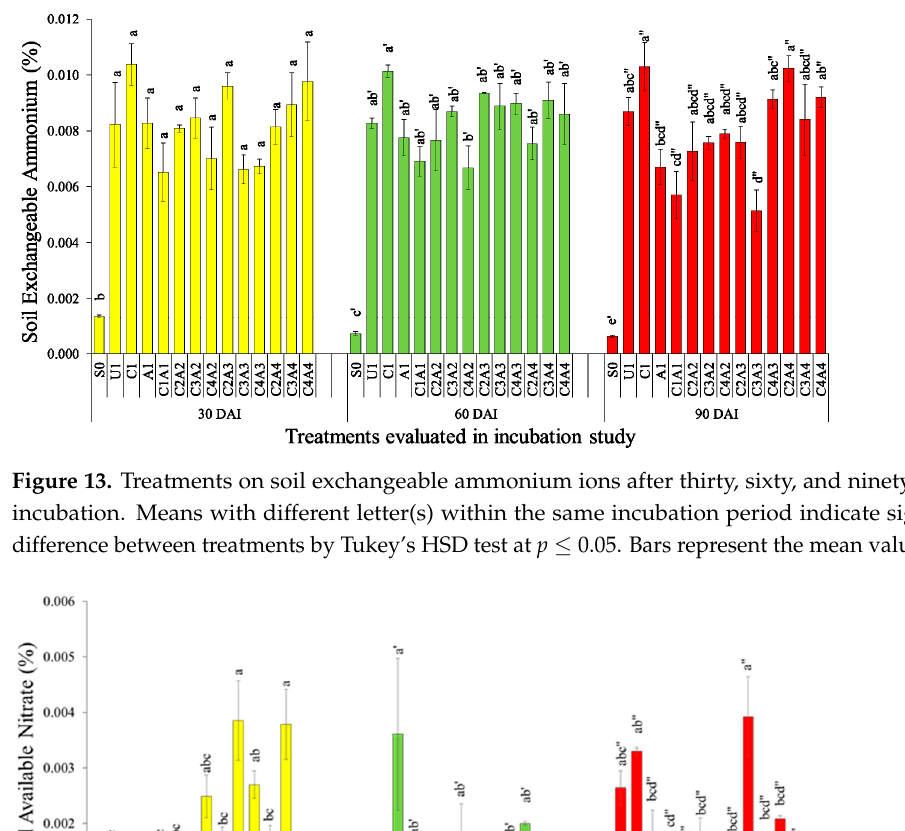
Figure 12. Treatments on soil total nitrogen after thirty, sixty, and ninety days of incubation. Means with different letter(s) within the same incubation period indicate significant difference between treatments by Tukey ’ s HSD test at p ≤ 0.05. Bars represent the mean values ± SE.